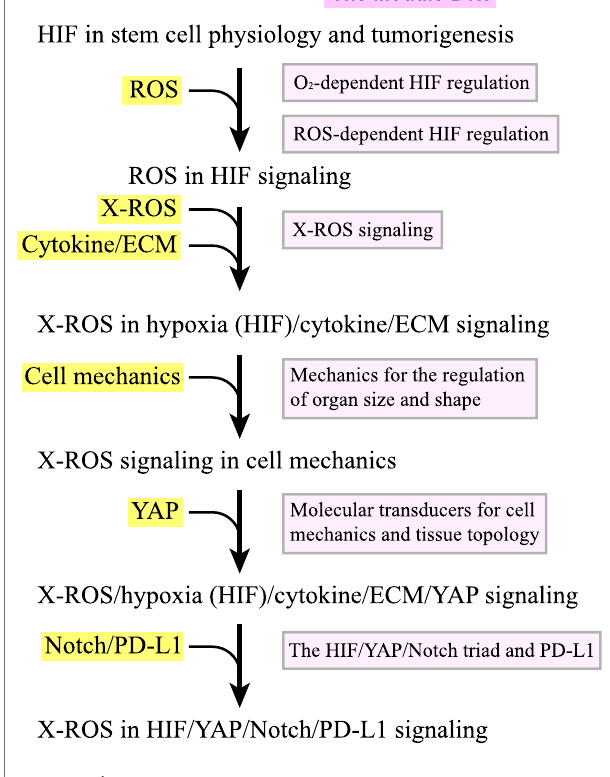
FIGURE1| The fl ow(inblack)ofintroducingthecouplingsintheX-ROS, HIF,YAP,Notch,andPD-L1signalingaxis.Eachcouplingisassociatedwitha module box (in pink) in the supporting boxes where detailed information and references can be